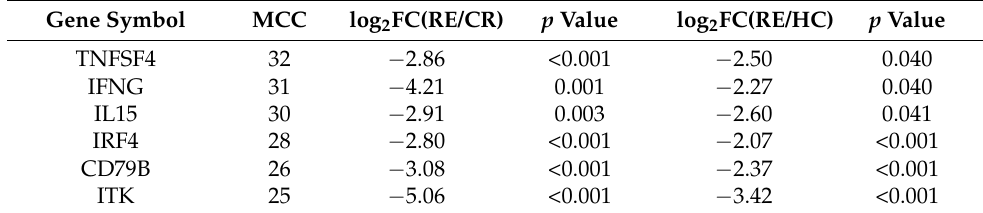
Figure 7. Validation of DE circRNAs in AML patients with pairwise diagnosis (DX) and relapse (RE) and controls (CR or HC) . The RT-qPCR detected the relative expression levels of DE circRNAs ( A , B ) and their associated DE miRNAs ( C , D ) and DE mRNAs ( E , F ), which were selected randomly from the ceRNA regulatory network in an independent cohort ( n = 6 per group). * p < 0.05; ** p < 0.01; *** p < 0.001.